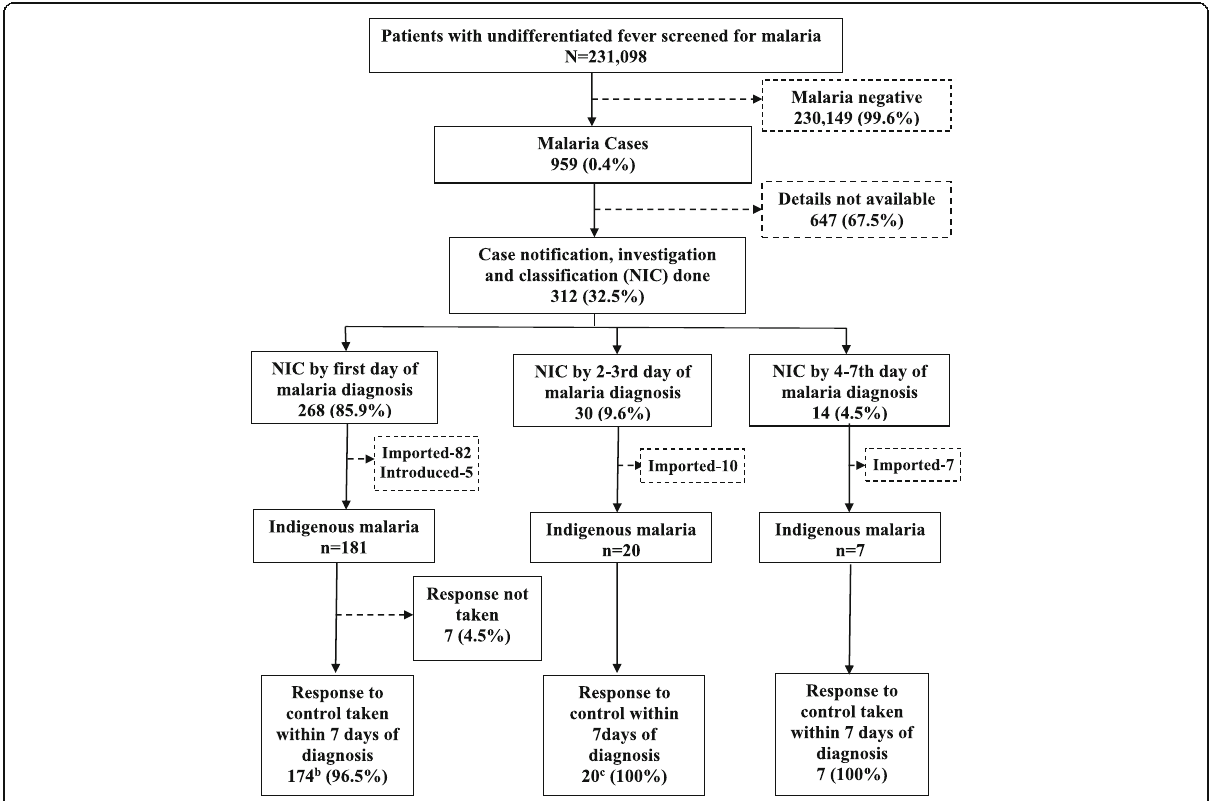
Fig. 3 The surveillance and response strategy for malaria elimination in low-endemic settings of Myanmar,